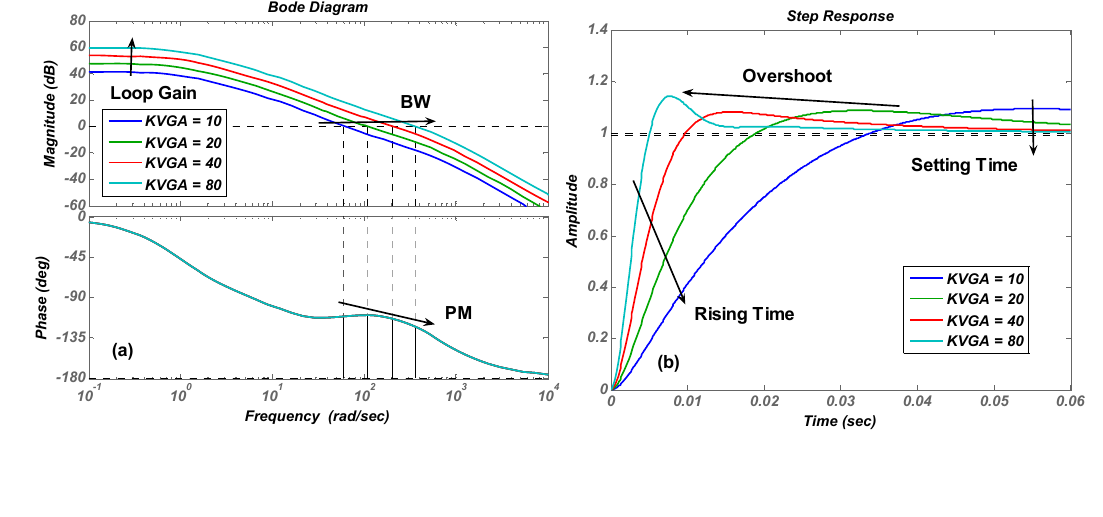
Figure 8. ( a ) Bode diagrams of the control loop ( b ) step responses of the linear model ( c ) and step responses of nonlinear model varying with the VGA gain coefficient K